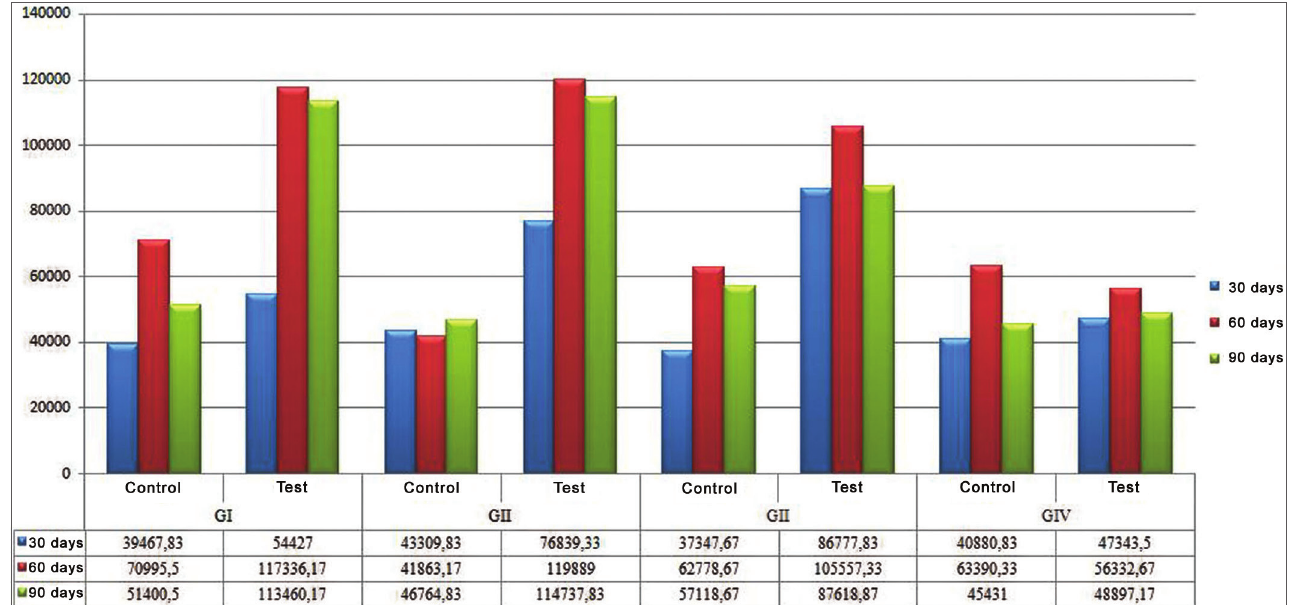
Chart 1. Control and test groups’ histomorphometric evaluation by assessment of time and according to the material tested. - Blue: 30 days, Red: 60 days, Green: 90 days.